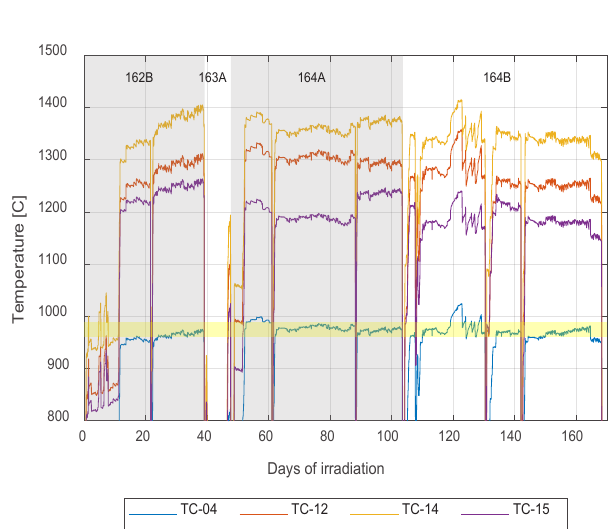
Fig. 8. Capsule 1 selected thermocouple